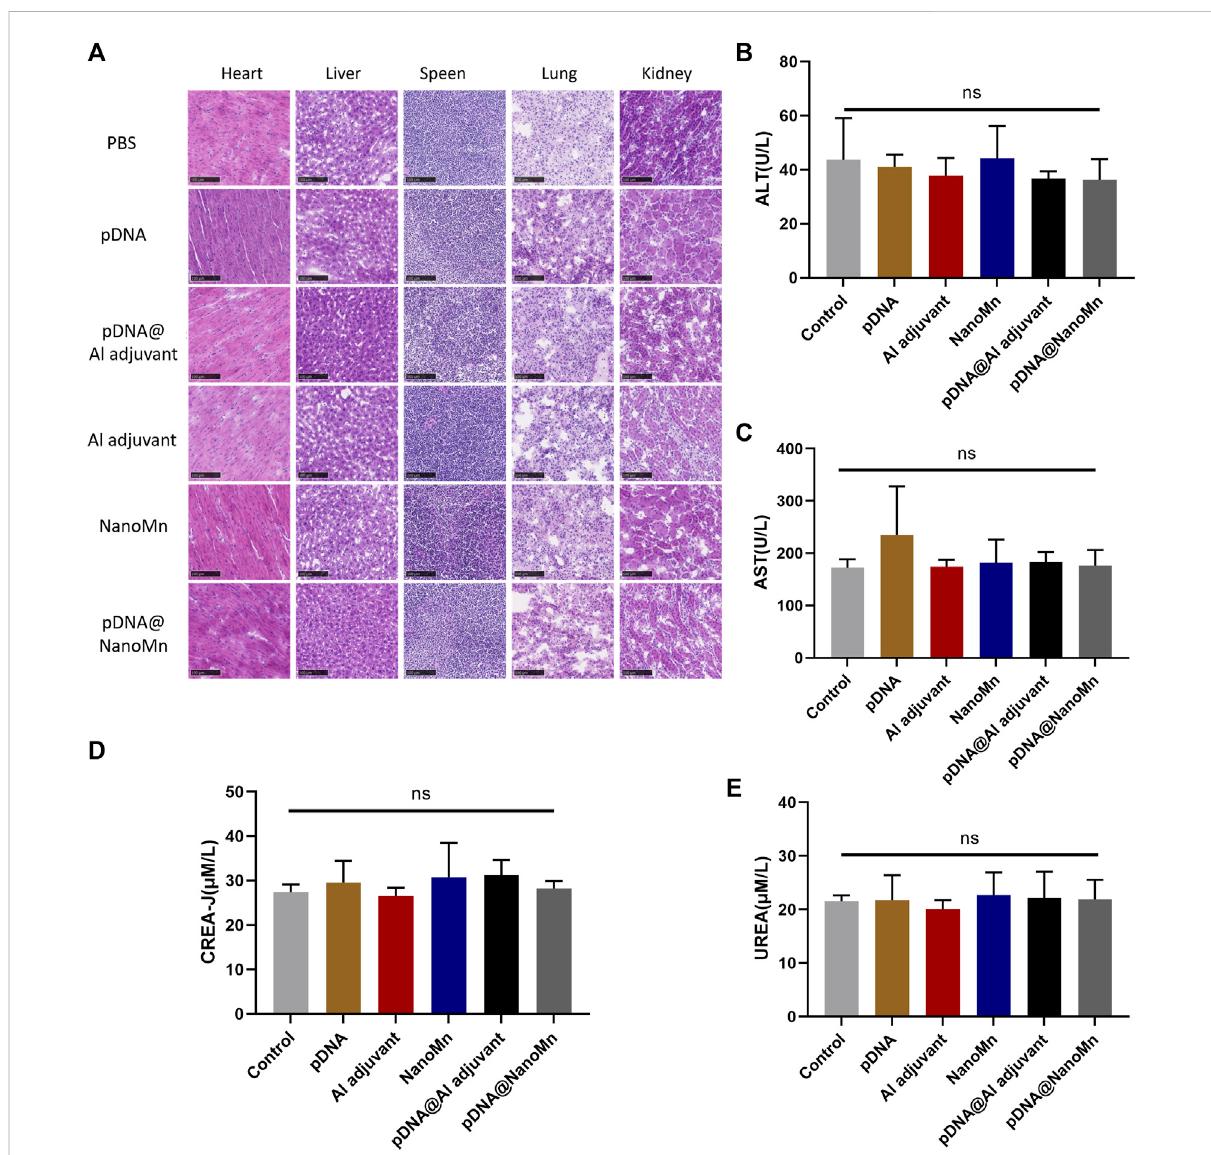
FIGURE 5 In vivo safetyveri fi cation ofpDNA HA Re11@NanoMn. (A) H&E staining ofmouse vitalorgans (heart, liver, spleen, lung, andkidney) 28 days after immunization with different formulations. (B,C) Changes of liver function indexes (AST, ALT) in blood biochemistry of mice after immunization with different preparations for 28 days (D,E) Changes of renal function indexes (CREA-J, UREA) in blood biochemistry of mice after immunization with different preparations for 28